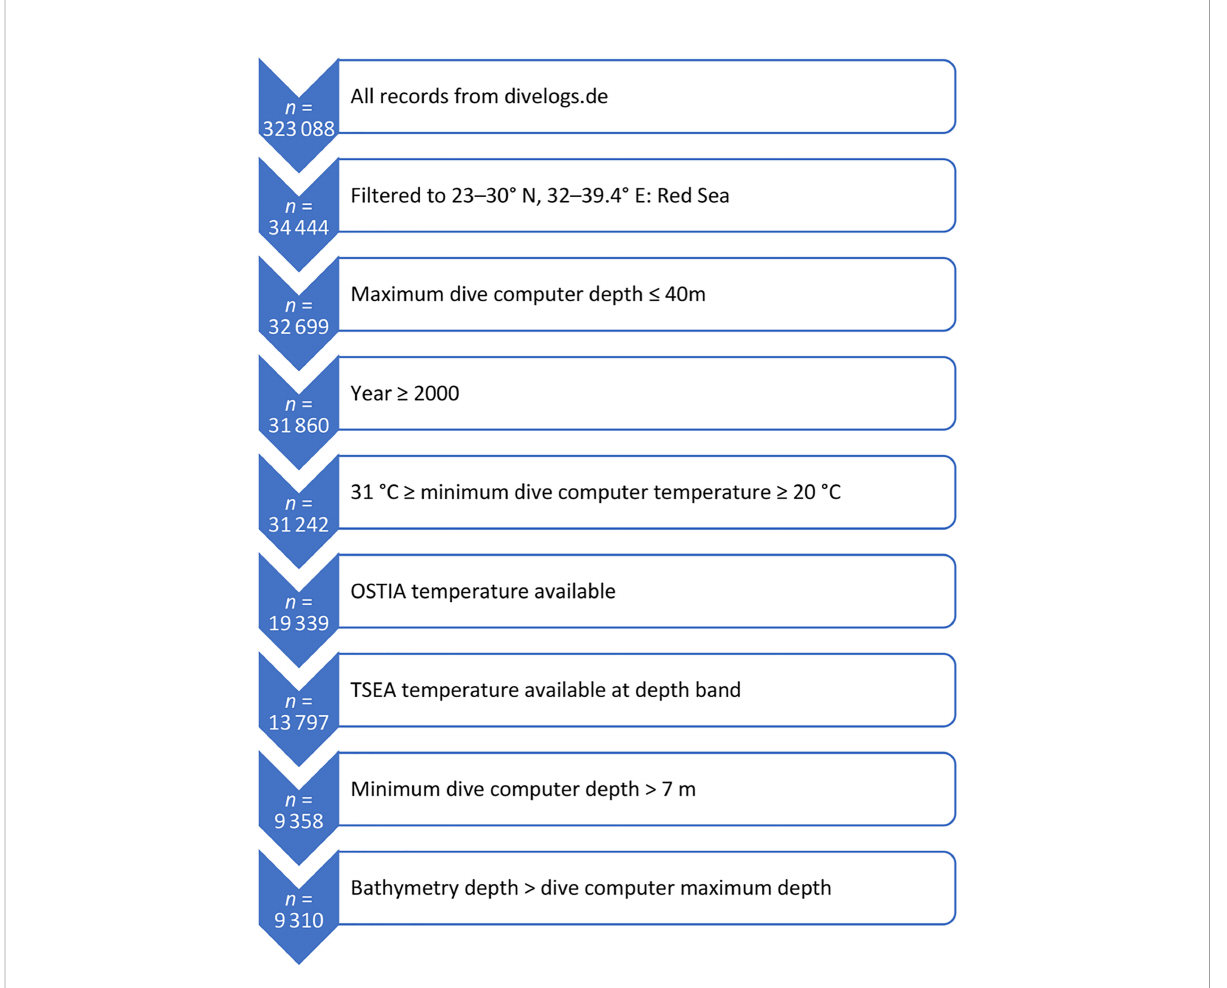
FIGURE 1 Flow chart showing the fi ltering process and n(dives) retained at each